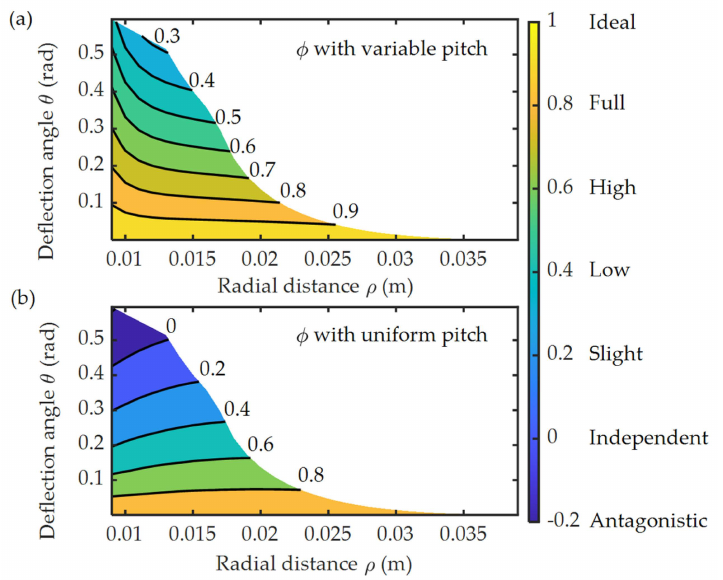
Figure 11. Load ratio comparison of configuration II (variable pitch vs. uniform